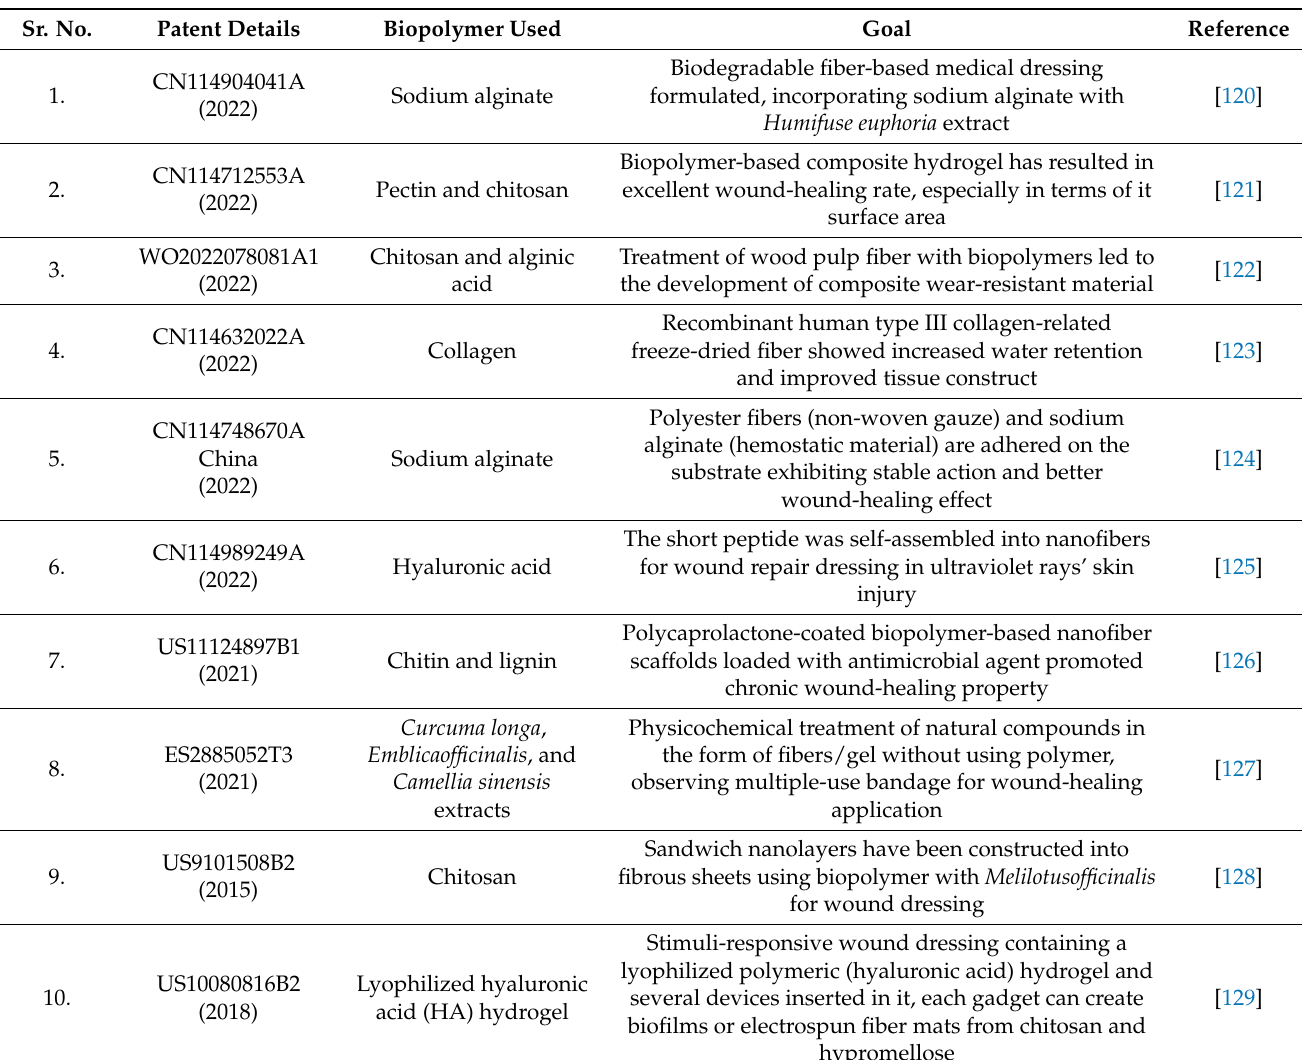
Table 2. Recent Patent